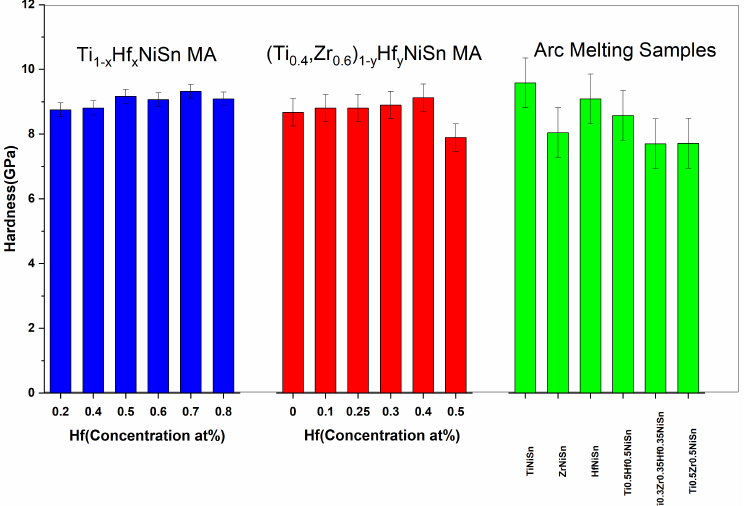
Figure 11. Hardness vs. Hf concentration for the Ti 1 − x Hf x NiSn samples and for the (Ti 0.4 ,Zr 0.6 ) 1 − y Hf y NiSn samples, and comparison with arc melted samples in the